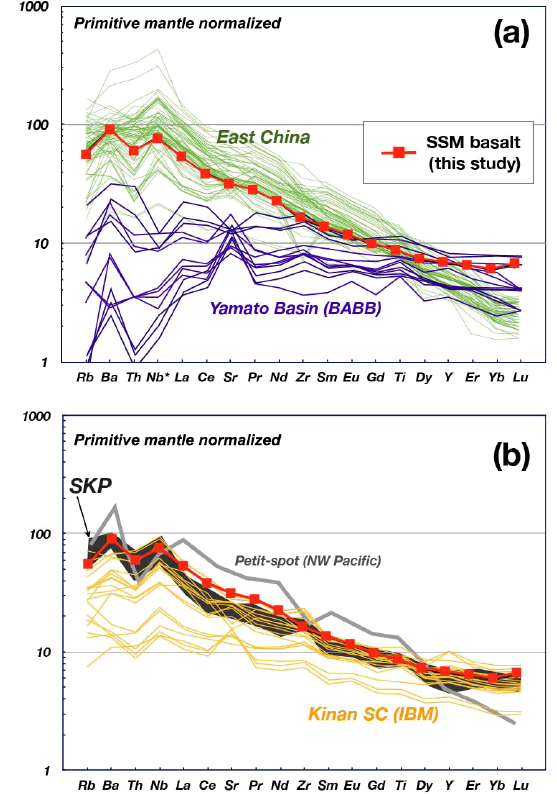
Figure 4. Primitive-mantle-normalized trace element pattern of the basalt from the Seifu Seamount (SSM basalt). Normalizing values (primitive mantle) are from Sun and McDonough (1989). Repre- sentative basalts from the circum-Sea of Japan area are shown for comparison (see Fig. 2 for the data sources). Back-arc basin basaltic (BABB) magmatism from Yamato Basin and alkali basalts from east China are shown in (a) . Alkali basalts from the South Korean Plateau (SKP) (black field) are shown in (b) . Data for the Kinan Seamount Chain in the Shikoku Basin (Izu–Bonin–Mariana region) and petit-spot volcanoes in the western Pacific are from Ishizuka et al. (2009) and Hirano et al. (2006), respectively. In (a) , Nb ∗ was calculated by assuming that Nb PM / Ta PM =